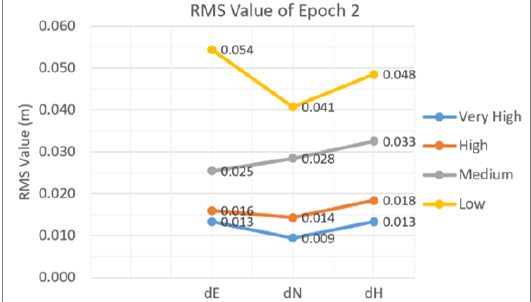
Figure 52. RMS values of coordinate differences between point cloud data by picking point manually and Total Station data using intersection method (epoch 1 and 2) 4.3.3 Figure 53. The generated displacement map and the RMS value for the point-pair registration error with respect to the four different scan